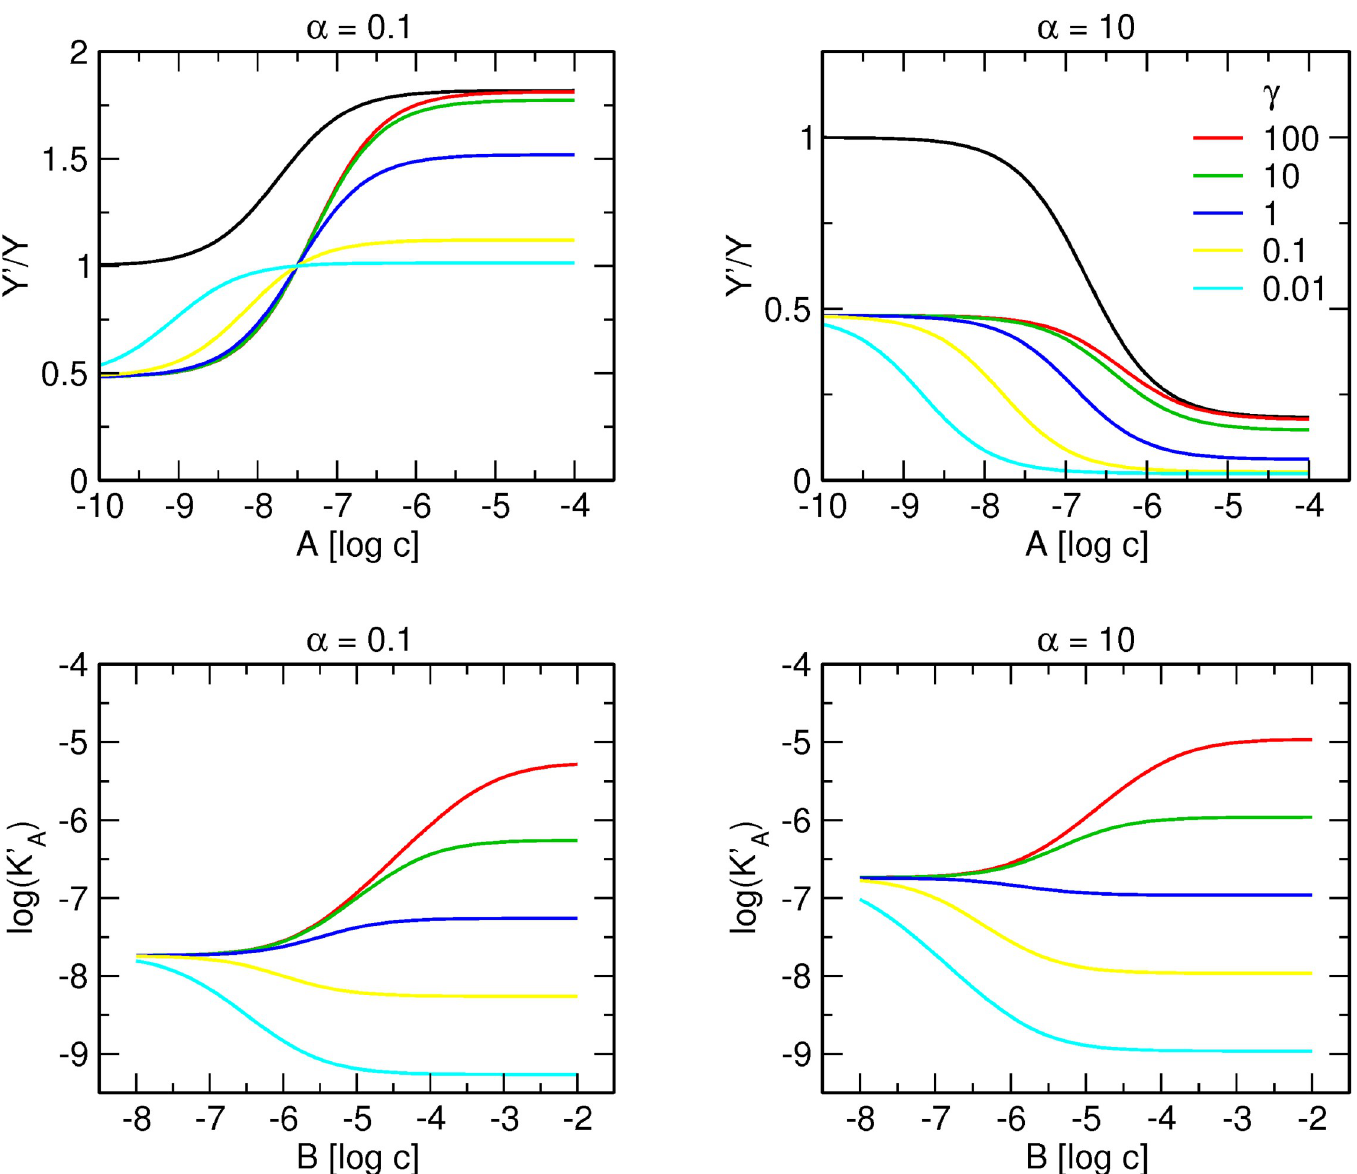
Fig 6. Effect of cooperativity factor γ on the interaction of two allosteric modulators binding each to its own allosteric site. Upper row, simulation of tracer binding (ordinate) in the presence two allosteric modulators A and B each binding to its own site, where A is either positive (left) or negative (right) and B is negative allosteric modulator. Binding of the tracer is expressed as the ratio to the binding in the absence of allosteric modulators. Abscissa, concentration of allosteric modulator A expressed as logarithm of molar concentration. Value of cooperativity factor γ is shown in the graph legend. Simulation parameters: K X = 0.1 nM, [X] = 0.1 nM, K A = 100 nM, K B = 1 μ M, β = 10, log[B] = -5.5, δ = 1. Lower row, dependence of the apparent equilibrium dissociation constant of modulator A (K’ A ) on concentration of modulator B for various values of cooperativity factor γ